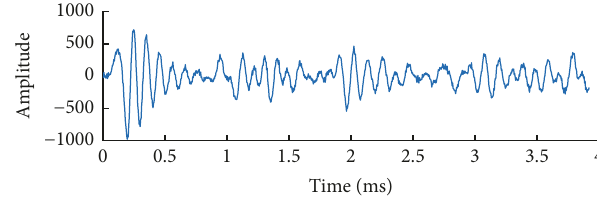
Figure 9: Bolt detection signal in actual engineering.